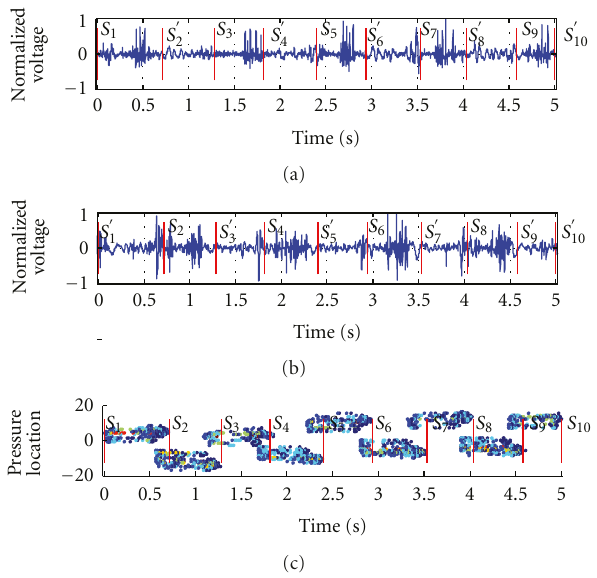
Figure 8: EMG signals of (a) left gastrocnemius (b) right gas- trocnemius, and (c) pressure walkway recording, with swing phase divisions shown in red for hypertensive subject 004 walk